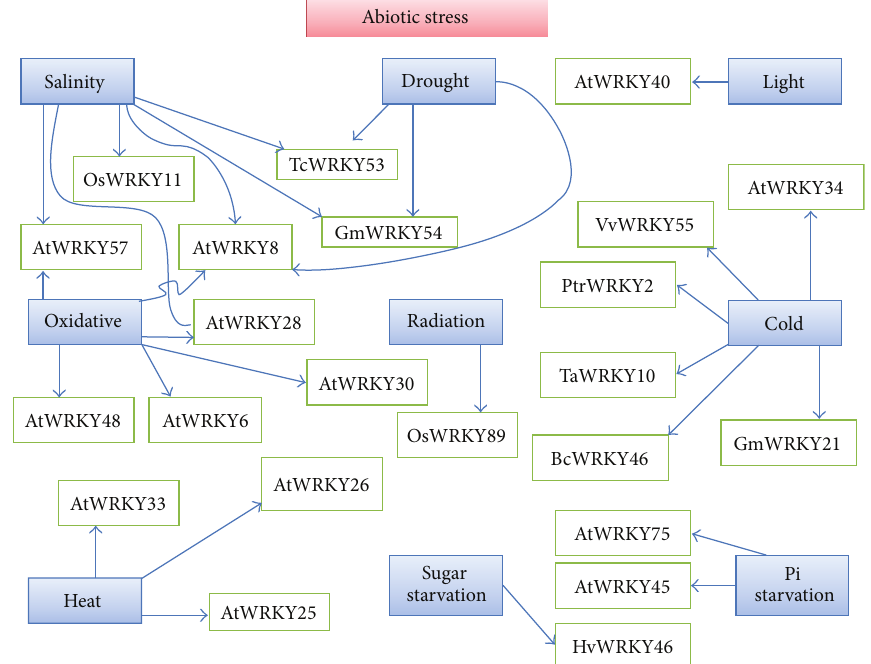
Figure 2: WRKY proteins regulating plant responses against multiple abiotic stresses like salinity, drought, heat, cold, nutrient starvation, light, radiation, and oxidative stresses. “At”refers to Arabidopsis thaliana , “Os”refers to Oryza sativa , “Gm” refers to Glycine max , “Vv” refers to Vitis vinifera , “Hv” refers to Hordeum vulgare , “Ta” refers to Triticum aestivum , “Bc” refers to Brassica campestris , and “Ptr” refers to Poncirus trifoliata